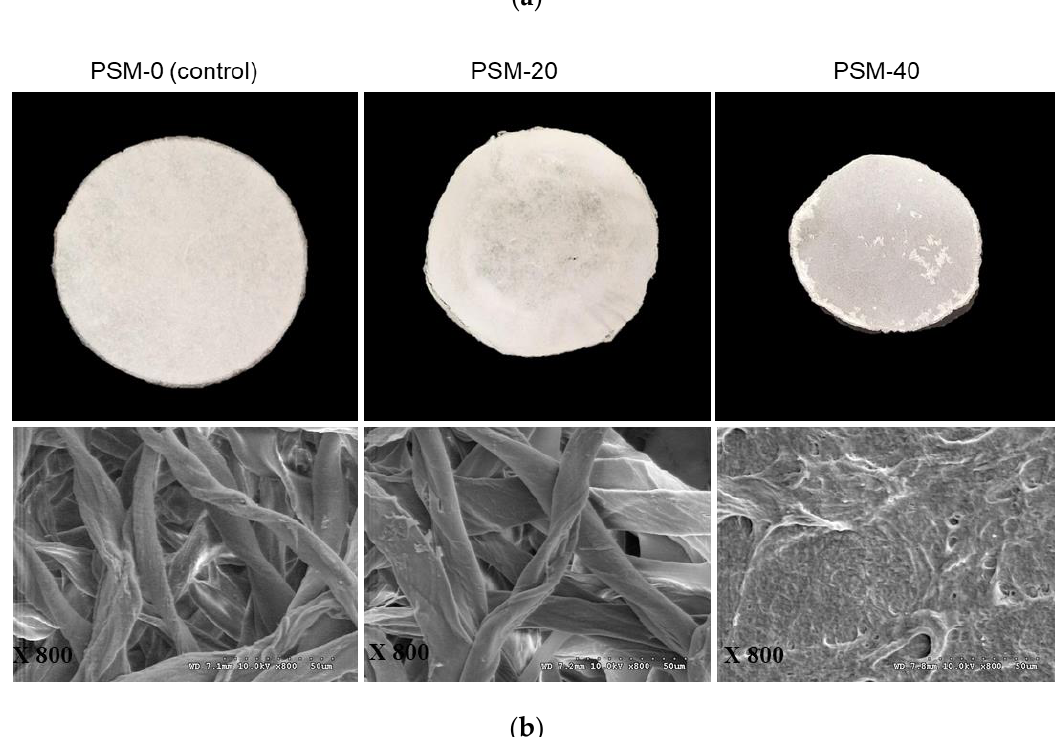
Figure 5. Preparation of cellulose films from plasma surface modified (PSM) cotton fibers and their morphological characterization. ( a ) Preparation of cellulose films through casting, gelation, regeneration, and hot-pressing and ( b ) Visual images (top) and SEM micrographs (bottom) (magnification: × 800) of regenerated cellulose films prepared from PSM cotton fibers (PSM-0 (control), PSM-20, and PSM-40).